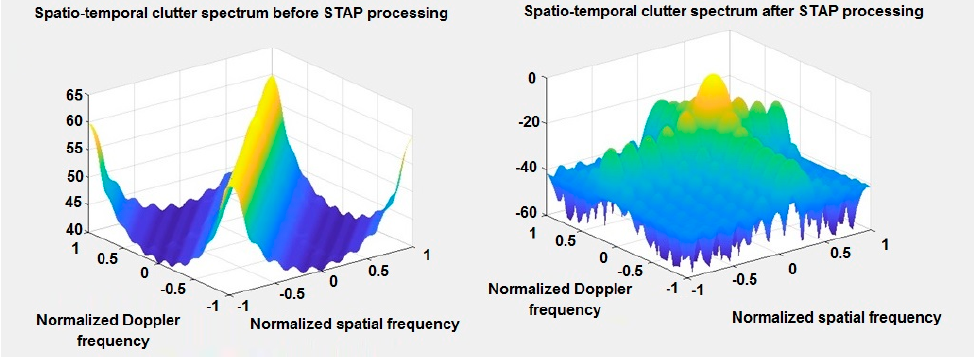
Figure 4. Space-time spectrum of clutter before and after STAP processing—3D charts.